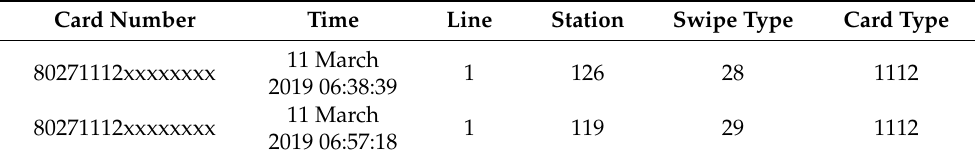
Table 1. Example of Wuhan rail transit smart card